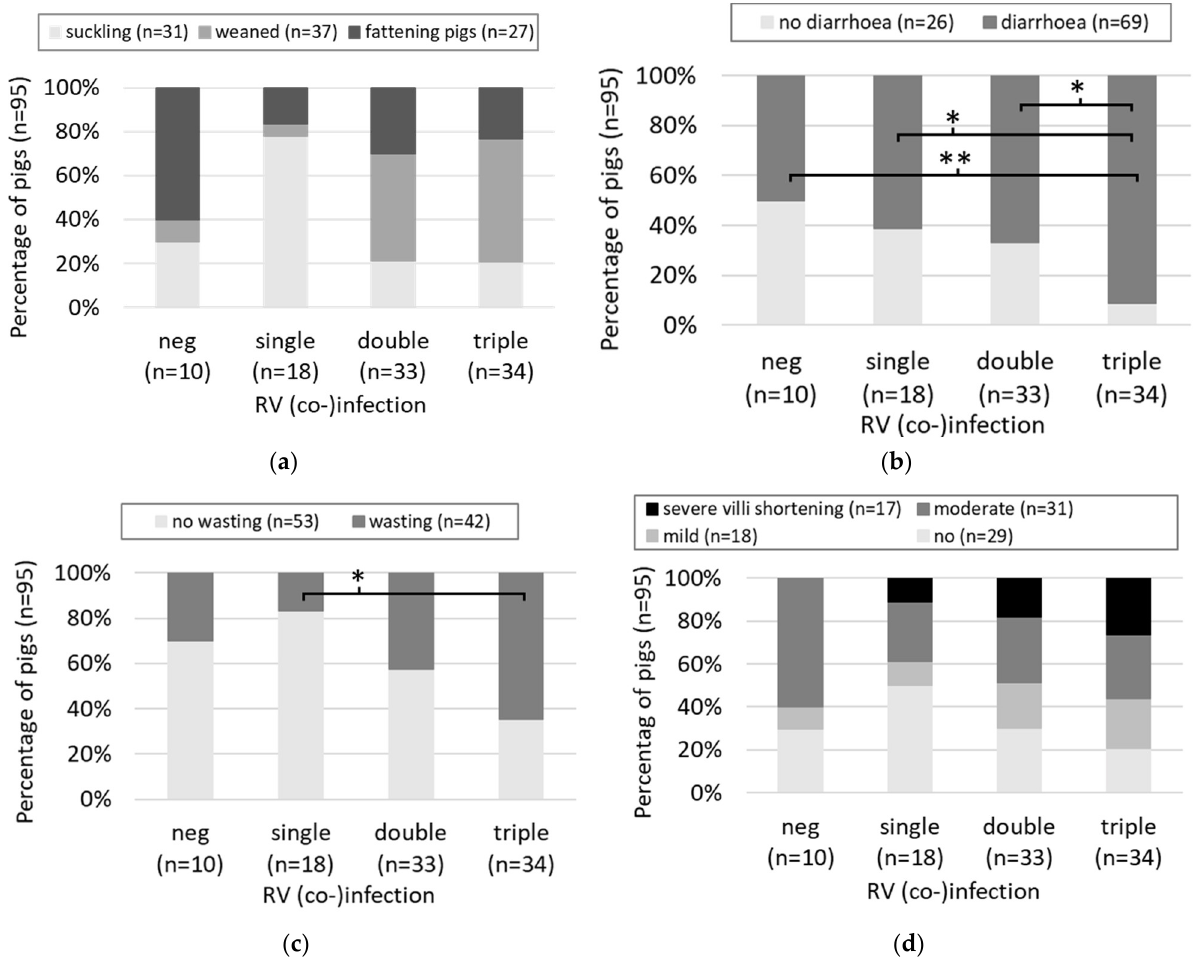
Figure 1. The percentage of animals from the cross-sectional study ( n = 95) infected with none, a single, two, or three RV species and ( a ) grouped by age group, ( b ) by absence/presence of diarrhea, ( c ) by absence/presence of wasting, and ( d ) by degrees of VCR, are shown. Statistically significant differences are indicated by asterisks (* p < 0.05, and ** p < 0.005).